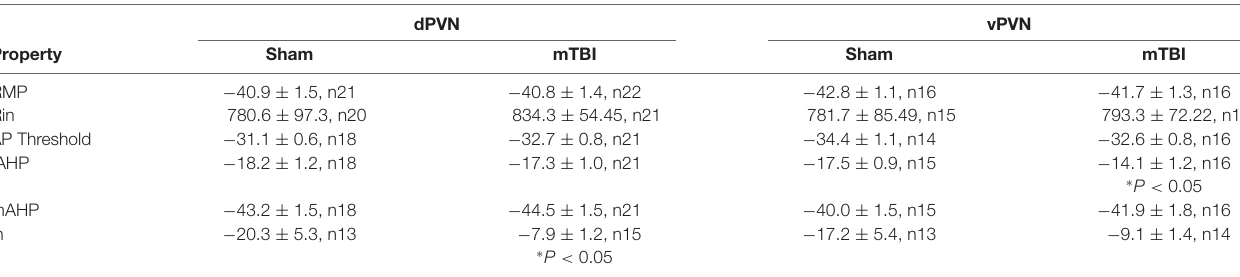
Table shows the intrinsic membrane and AP properties across dPVN and vPVN CRF neurons in sham and mTBI. Unpaired Student’s t-test, ∗ p < 0.05 noted for the statistical significance in comparisons between sham and mbTBI mice.